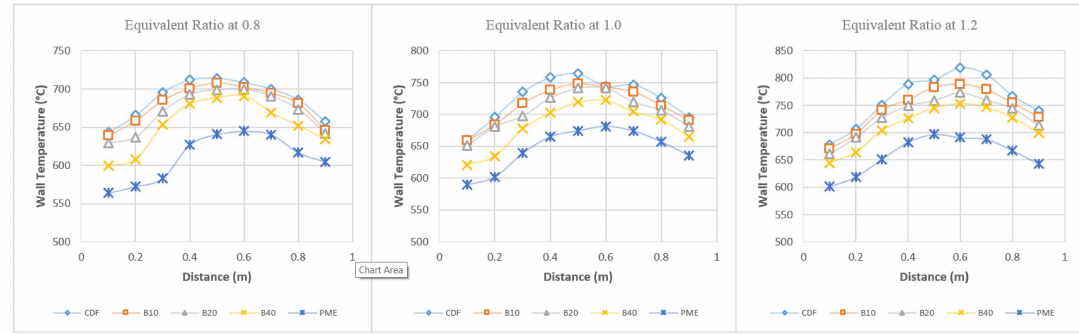
Figure 6. Wall temperature profiles for the 1.75